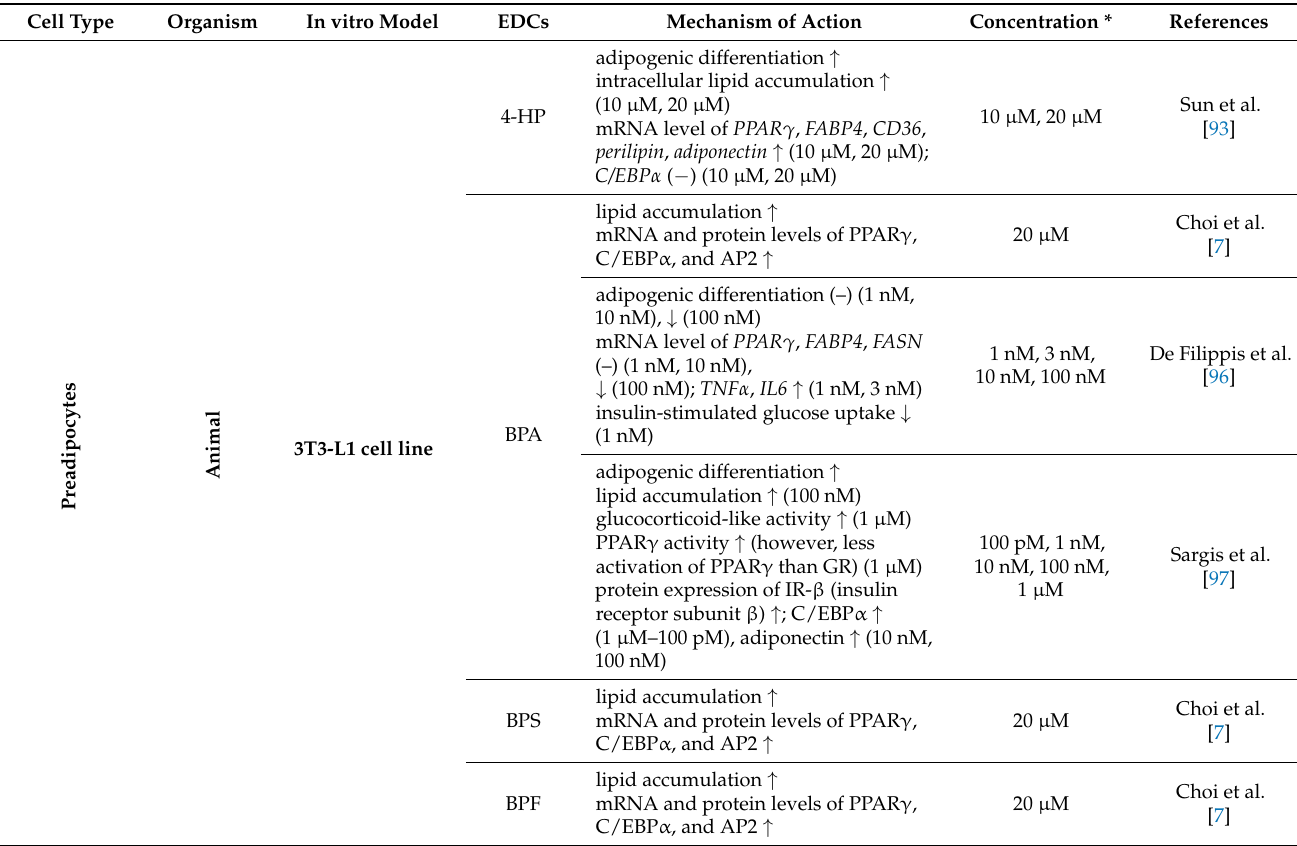
Table 1. The obesogenic effects of selected EDCs confirmed on adipose tissue cell